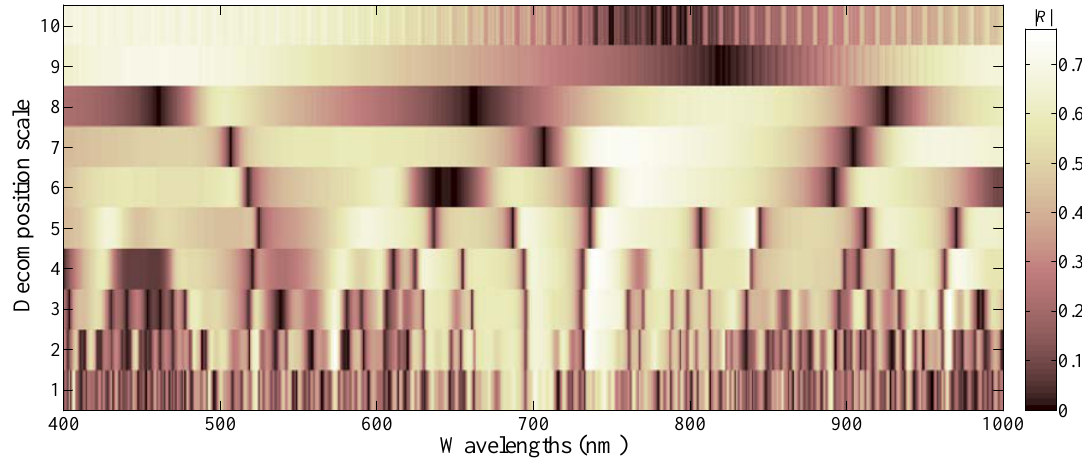
Figure 8. Correlation coefficients map between wavelet features and growth stages.